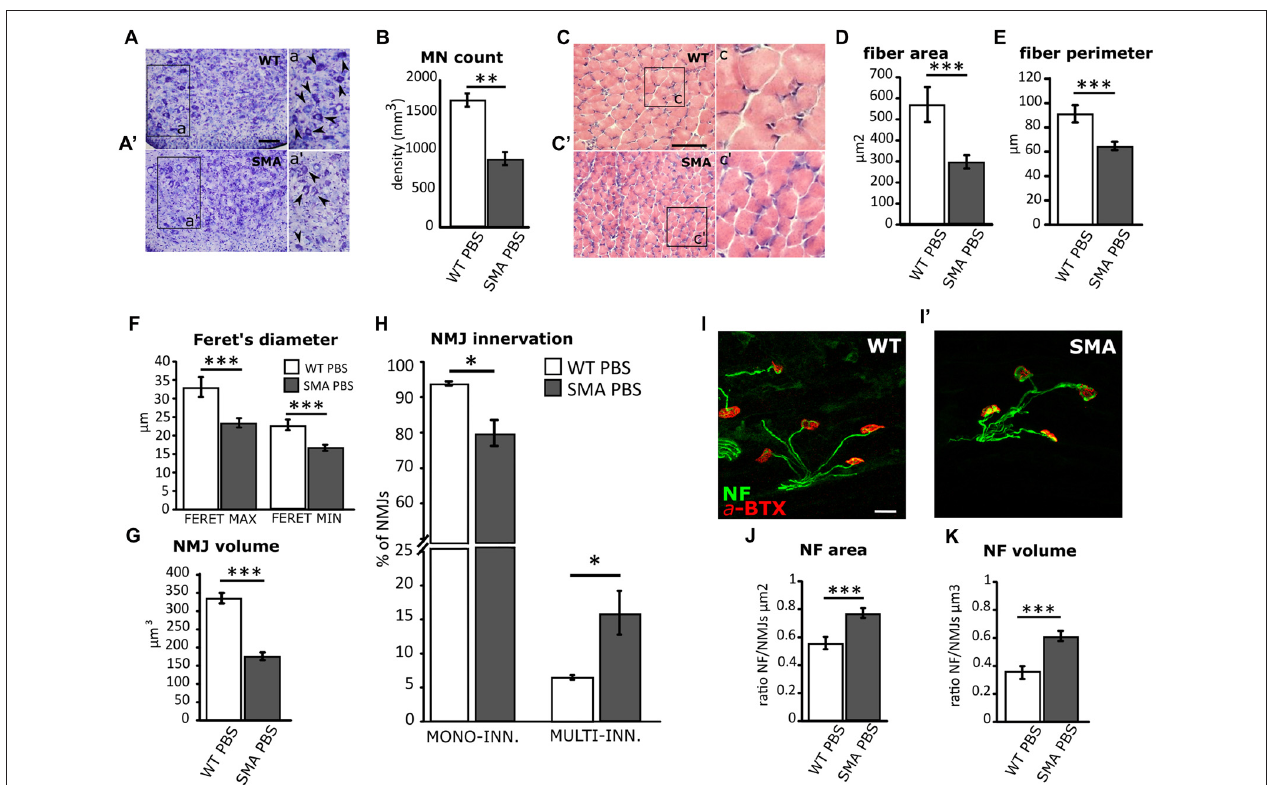
FIGURE 2 | Comparison of MN survival and muscular fiber dimension and innervation between WT and SMA mice at P12. (A,A’) Nissl-stained MNs in the ventral horns of WT and SMA mice spinal cord. Arrowheads indicate MN in the higher magnification insets a,a’. (B) Quantification of MN density between WT and SMA mice. (C,C’) Hematoxylin/eosin (H/E)-stained representative images showing WT and SMA quadriceps fibers. Insets c,c’ show higher magnification of the muscular fibers. (D) Analysis of muscle fiber area in WT and SMA mice. (E) Analysis of muscle fiber perimeter in WT and SMA mice. (F) Analysis of maximal and minimal Feret’s diameter of WT and SMA muscle fibers. (G) Quantification of neuromuscular junction (NMJ) volume. (H) Quantification of the percentage of mono and multi-innervated NMJs in WT mice and SMA littermates. (I,I’) Double immunostaining against α -bungarotoxin (BTX, in red) and neurofilament (NF, in green)